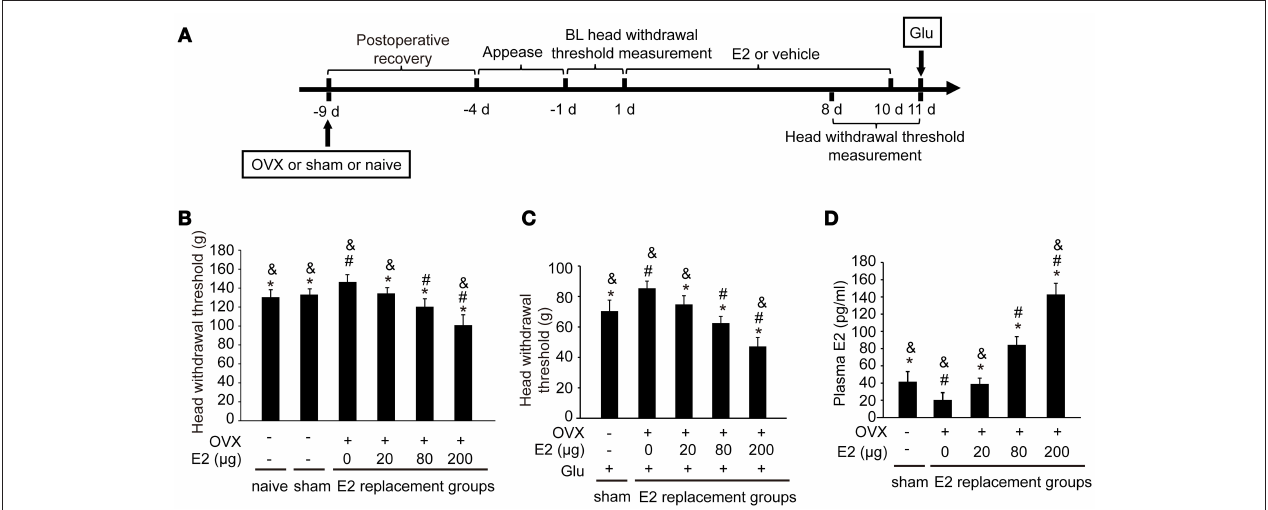
FIGURE 2 | E2 induced mechanical hypernociception and exacerbated glutamate-evoked masseter muscle hypernociception. (A) Schematic graph of E2 effects on glutamate-evoked masseter muscle hypernociception. The OVX rats were daily administered with E2 at doses of 0, 20, 80, or 200 µ g respectively for 10 days. The naïve and sham OVX groups received daily injections of vehicle. Head withdrawal thresholds were measured on day 8, 9, and 10 post-E2 or vehicle replacement. On day 11, rats in the sham OVX and OVX groups received glutamate injections into the masseter muscles and head withdrawal thresholds were measured 15min after glutamate injections and then rats were sacrificed and plasma E2 was quantified. (B) The effects of E2 on masseter muscle mechanical hypernociception. * P < 0.05 vs. 0 µ g E2 group; # P < 0.05 vs. 20 µ g E2 group; & P < 0.05 vs. 80 µ g E2 group; (C) The effects of E2 on glutamate-evoked masseter muscle mechanical hypernociception. * P < 0.05 vs. 0 µ g E2 group; # P < 0.05 vs. 20 µ g E2 group; & P < 0.05 vs. 80 µ g E2 group; (D) Plasma levels of E2. * P < 0.05 vs. 0 µ g E2 group; # P < 0.05 vs. 20 µ g E2 group; & P < 0.05 vs. 80 µ g E2 group; n = 6. BL, baseline; OVX, ovariectomy; E2, 17 β -estradiol; Glu, glutamate.